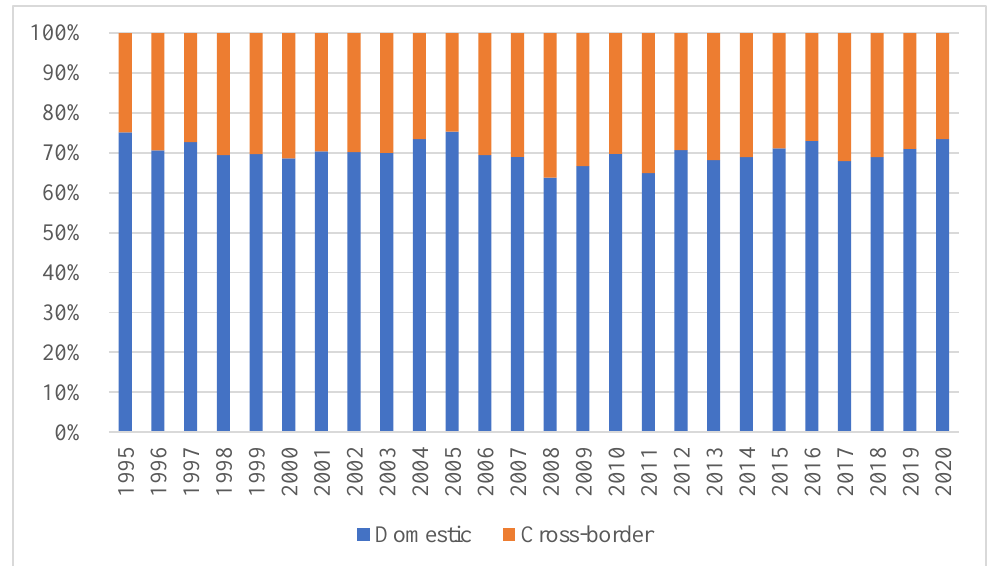
Figure 4. Dynamics of domestic vs. cross-border M&As in the energy industry.